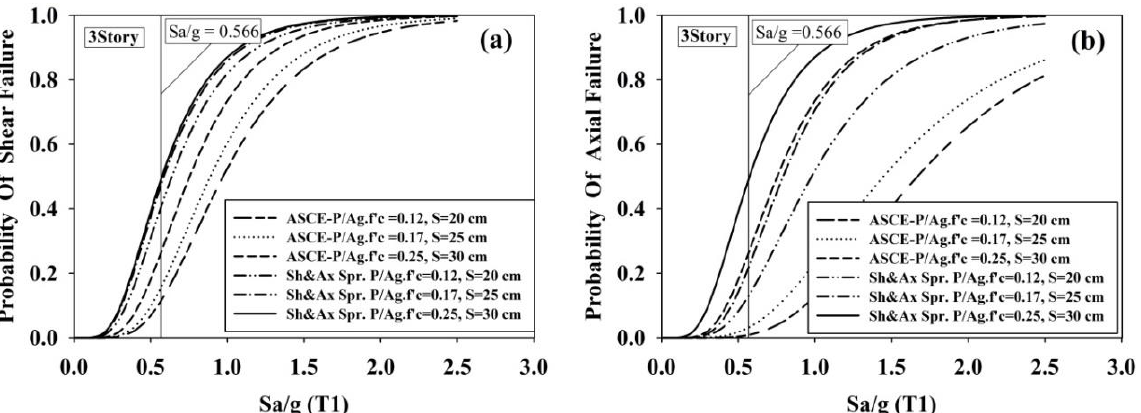
Fig. 14. Seismic fragility curves of shear and axial failure for the 3-story models, (a) probability of first shear failure, (b) probability of first axial